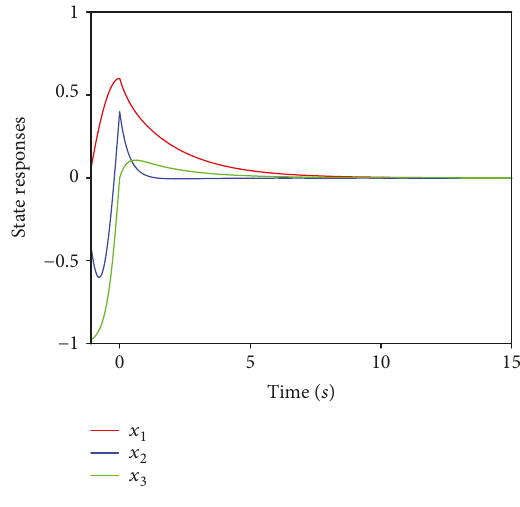
Figure 1: State responses of subnetwork 1 of the considered SNNs for Example 1 with the initial condition ψ s = cos s − 0 4 ; sin 2 s + 0 4 ; tanh 2 s T